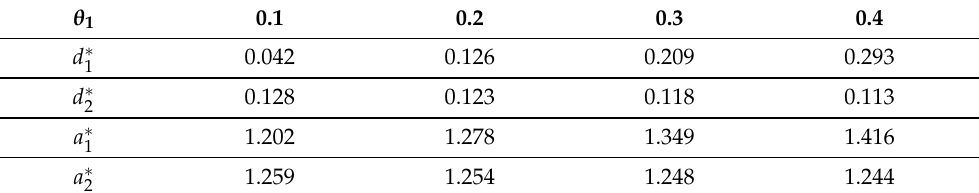
Table 1. The effects of θ 1